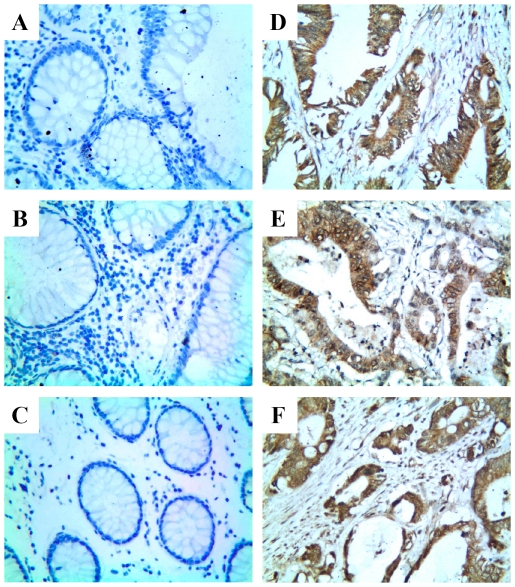
Representative examples of immunohistochemical staining of TLR4, MD-2, and CXCR7 in colorectal carcinoma tissues (original magnification 100×).Positive staining was observed as a dark brown color. Normal colorectal tissues showed negative immunohistochemical staining of TLR4 (A), MD-2 (B), and CXCR7 (C), and colorectal carcinoma tissues showed strong staining of TLR4 (D), MD-2 (E), and CXCR7 (F).